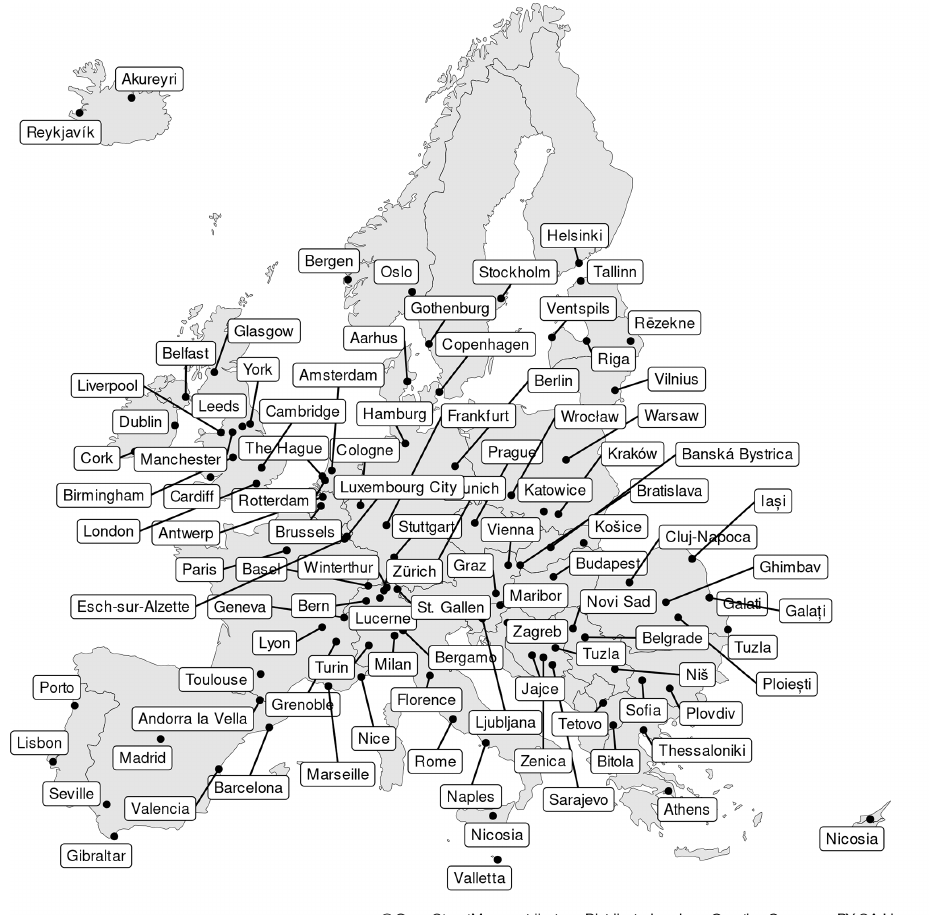
Figure 2. The 102 European urban areas included in the data